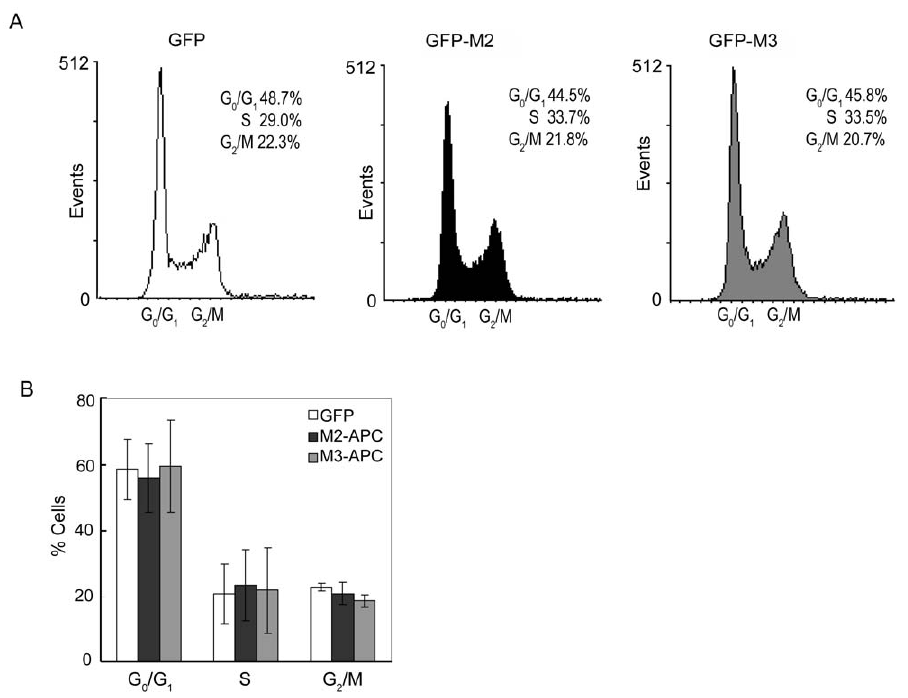
Figure 5. Expression of M2- or M3-APC does not affect cell cycle progression of colon cancer cells with endogenous truncated APC. (A) SW480 cells with endogenous truncated APC and expressing M2-, M3-APC or EGFP alone have similar cell cycle distributions. Histograms showing FACS analysis of EGFP-positive cells at 48 hours post-transfection. (B) Bar graphs show the average cell cycle distribution of SW480 cells expressing EGFP, M2 or M3-APC from three independent experiments. Error bars represent standard deviation.